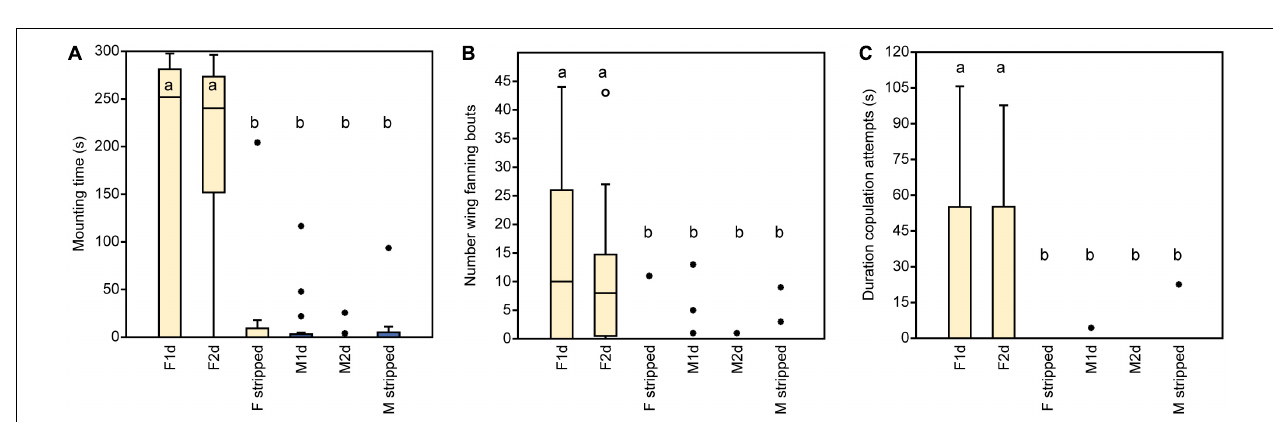
FIGURE 1 | Relative composition of cuticular hydrocarbons (CHCs) in whole body extracts from female (yellow columns) and male (blue columns) Urolepis rufipes . Individual peak areas were related to the largest peak with a linear retention index (LRI) of 3545 (=100%). Error bars represent standard errors of means. Asterisks indicate significant differences between males and females at p < 0.05 (Mann-Whitney U -test, n = 10 for each sex). LRIs refer to the compounds listed in Table 1 . Red arrows indicate the two female-biased CHCs 7-MeC31 and 7-MeC33.